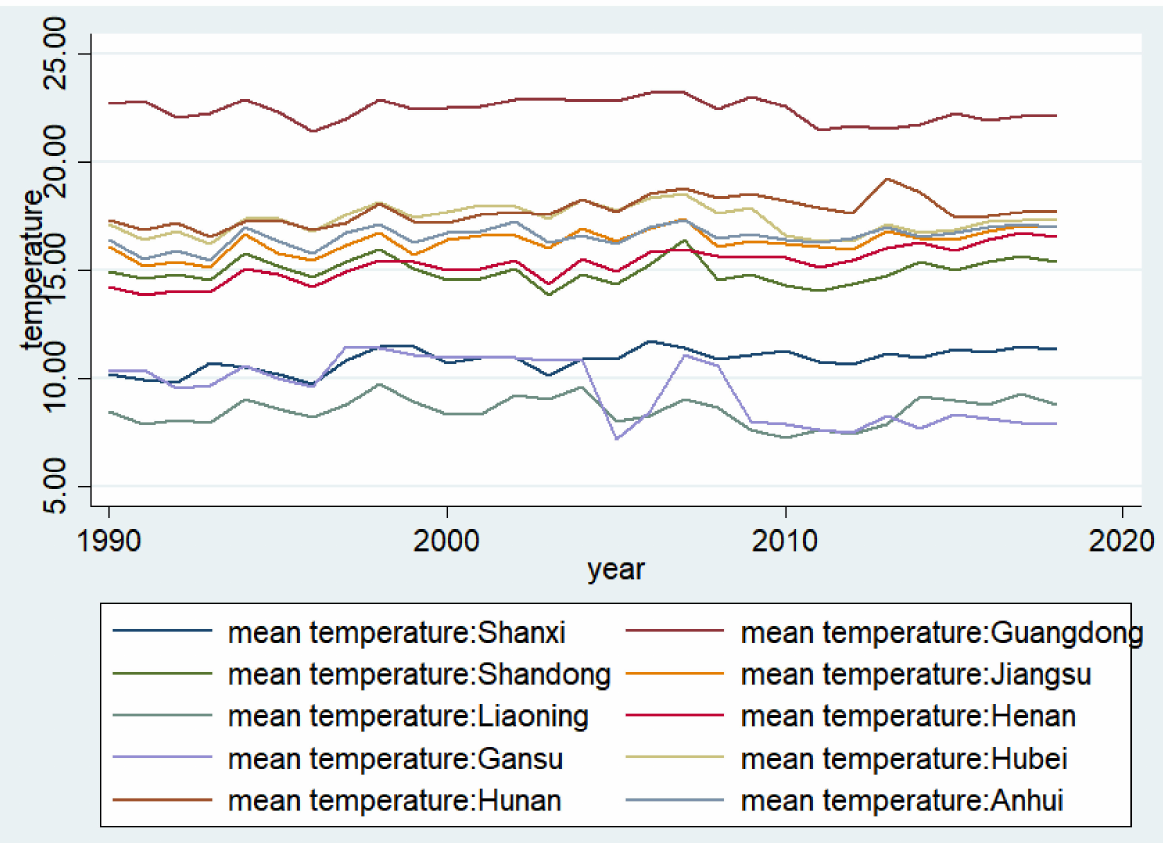
Figure 1. Average temperature by